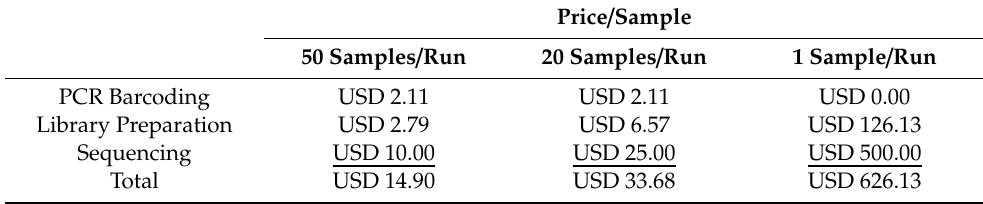
Table 3. Price of consumable reagents for MinION sequencing of rabies virus amplicons. Prices are based on reagents purchased in the United States as advertised on the Oxford Nanopore website at the time of sequencing (2018). Bulk price of USD 500 per flow cell was used. Shipping prices are not included. Prices may vary substantially depending on location and product